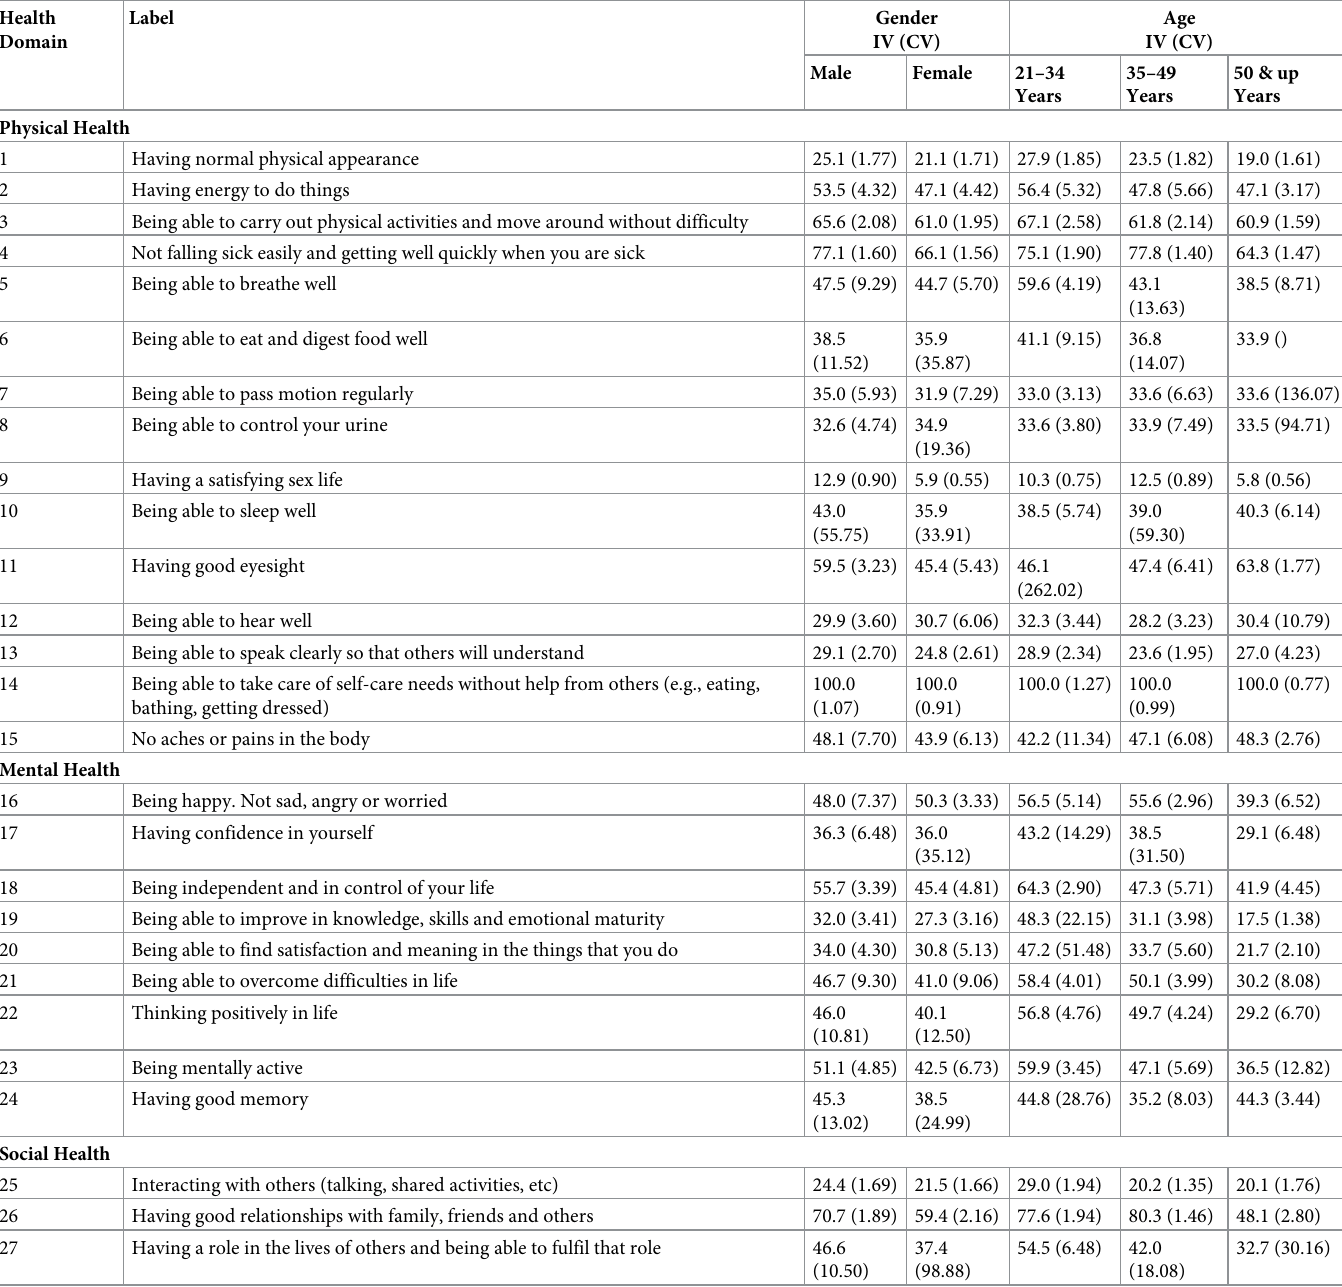
Table 5. Importance ranks (index values, IV) and consistency of ranks (coefficient of variation, CV) by gender and age group. Health